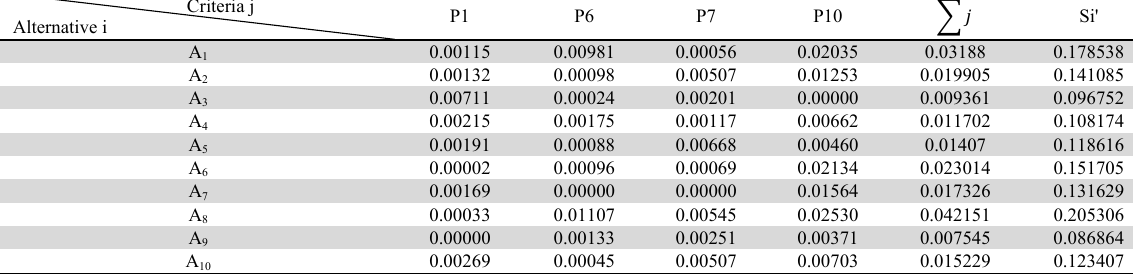
Negative ideal solution separation measurements